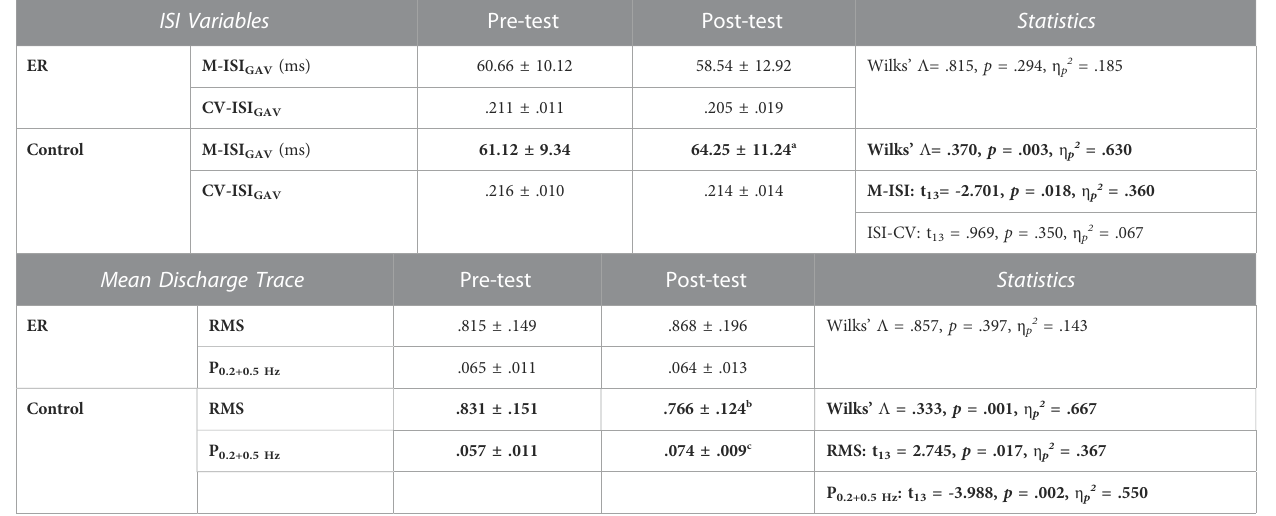
TABLE 2 Means and standard errors of variables of inter-spike interval (ISI) (A) and mean discharge trace (MDT) (B) in the pre-test and post-test for the ER and control groups. (M-ISI GAV = the averaged value of the mean inter-spike interval for all motor units; CV-ISI: the coef fi cient of variation of ISI; CV-ISI GAV : the mean value of the coef fi cient of variation of inter-spike intervals for all MUs; RMS: root mean square; P 0.2+0.5Hz : the combined amplitudes of the 0.2 Hz and 0.5 Hz spectral peaks).